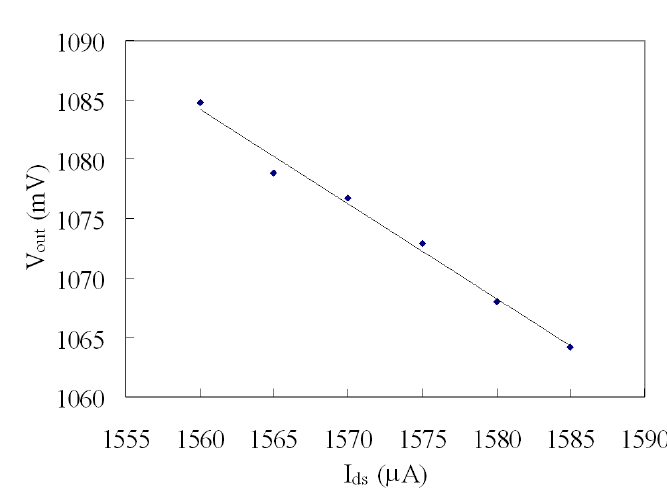
Figure 10. Simulated results of the readout circuits